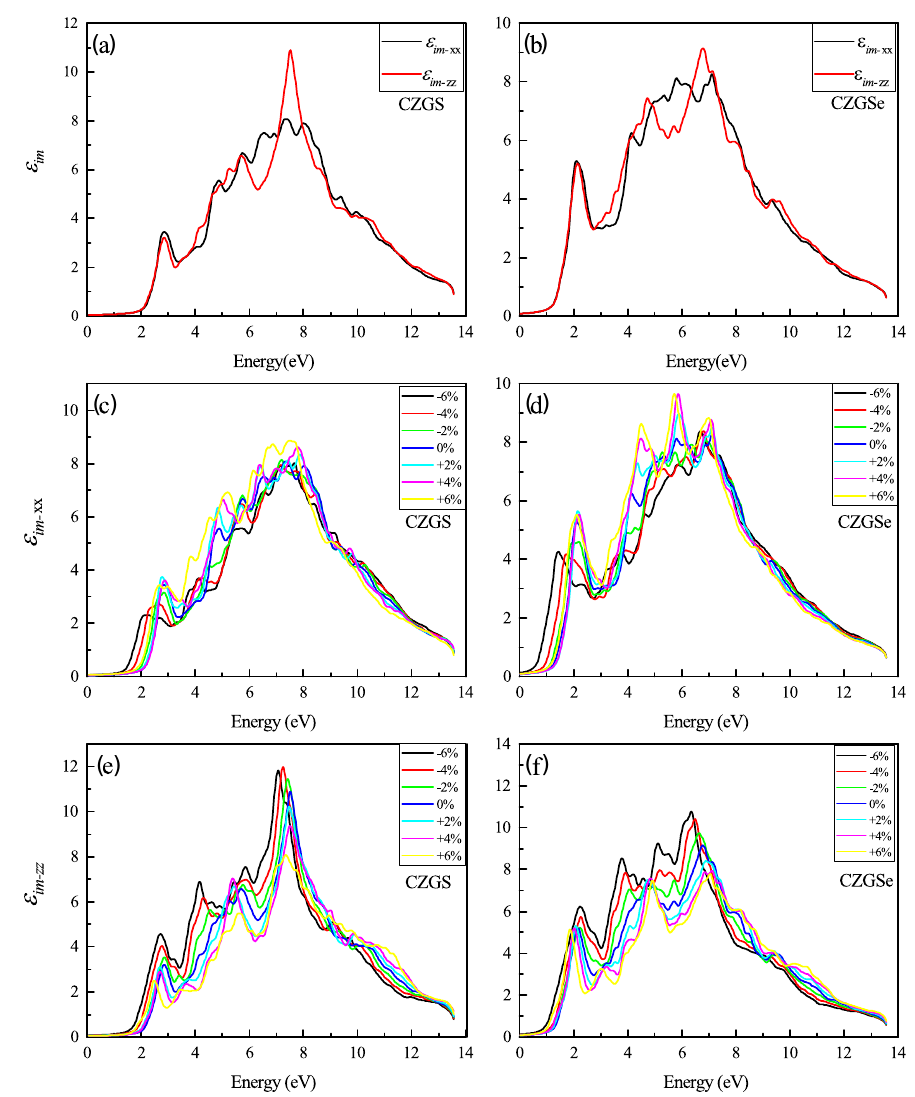
Figure 9. The variation of the imaginary part of the dielectric function spectra as a function of the incident photon energy for both materials CZGS and CZGSe: ( a , b ) are the unstrained cases, ( c – f ) are the strained cases. ε im − xx and ε im − zz are the imaginary parts of the dielectric function for light polarization along XX and ZZ directions